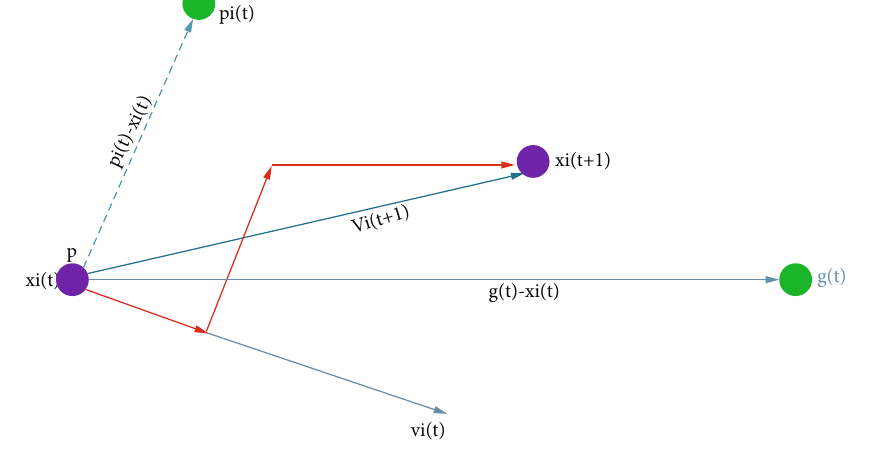
Figure 3: Graphical representation of PSO